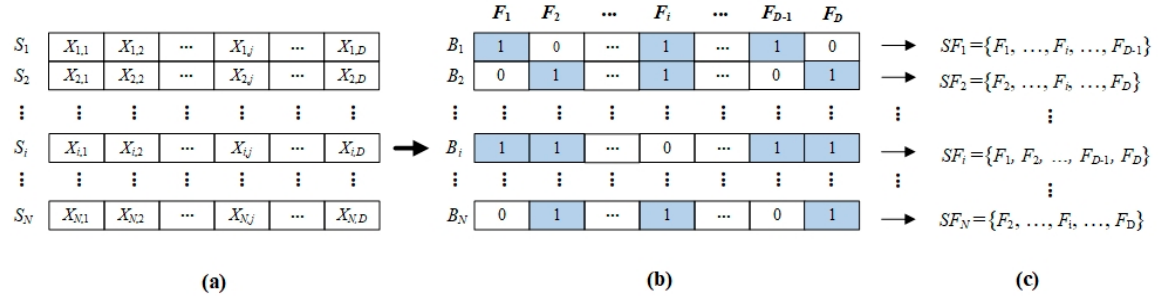
Figure 1. The representation scheme used by BSMO, ( a ) Starling population (Matrix X), ( b ) Binary population (Matrix B), and ( c ) Selected features (SF).